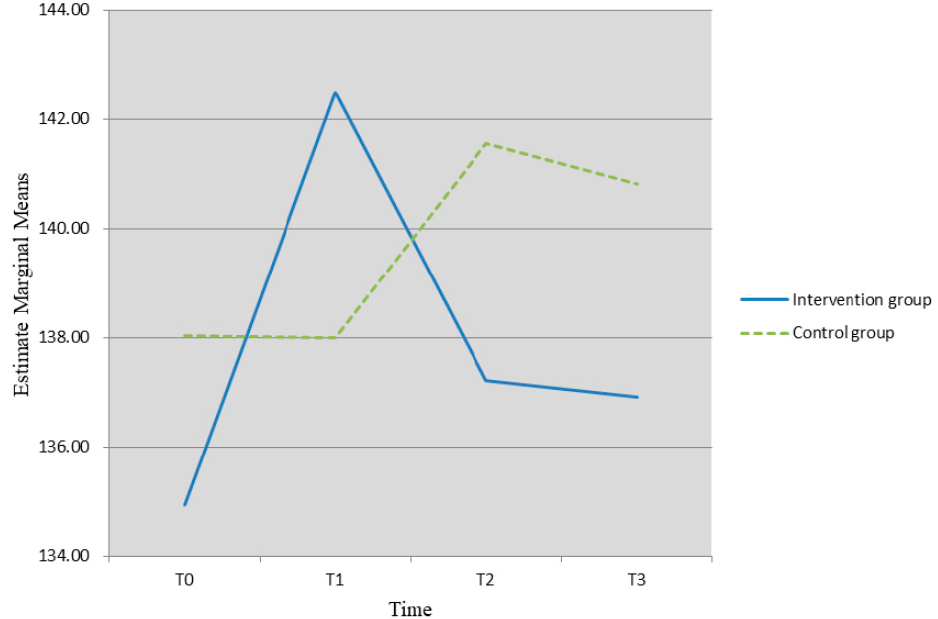
Figure 2. Change of QoL from T0 toT3 in intervention and control groups.